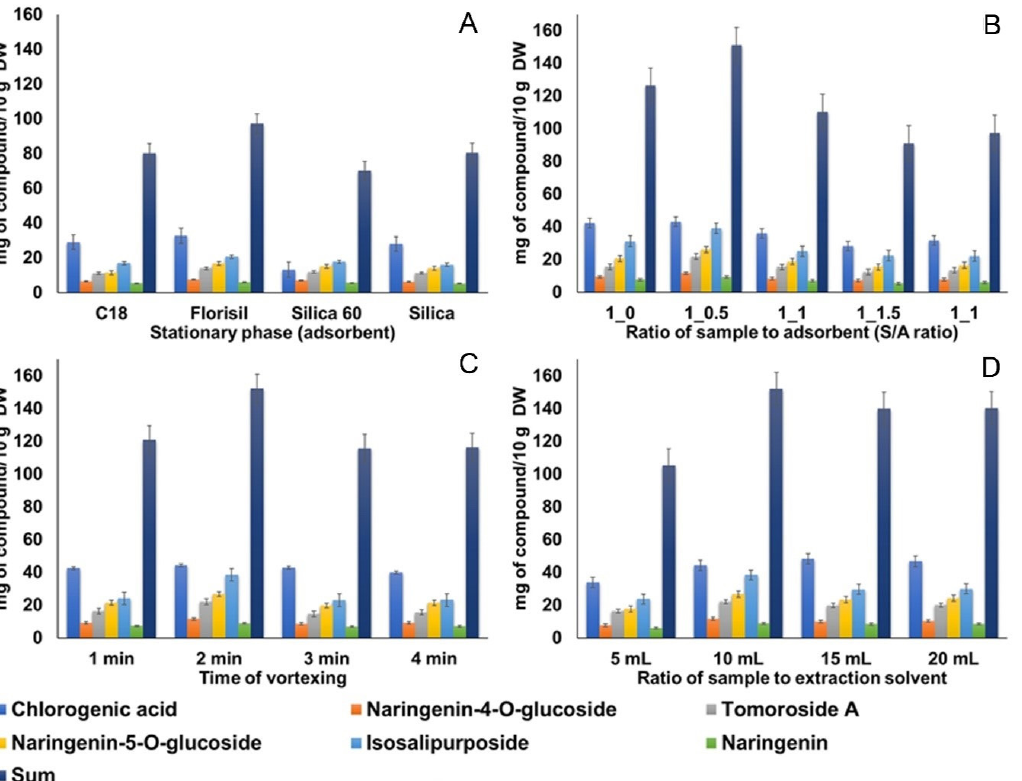
Figure 2. Influence of extraction parameters: ( A ) stationary phase selection (adsorbent); ( B ) ratio of sample to adsorbent (S/A ratio); ( C ) time of vortexing and ( D ) ratio of sample to extraction solvent on the extraction yield of individual phenolic compounds (mg/10 g DW) from H. arenarium inflorescences by